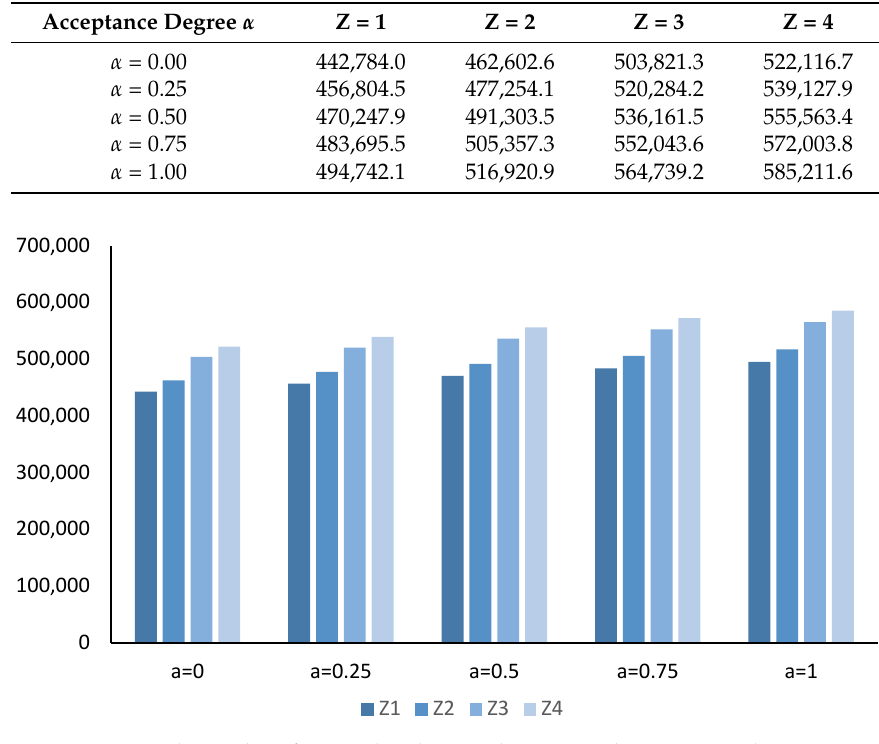
Figure 4. The total profit over the planning horizon with acceptance degrees.